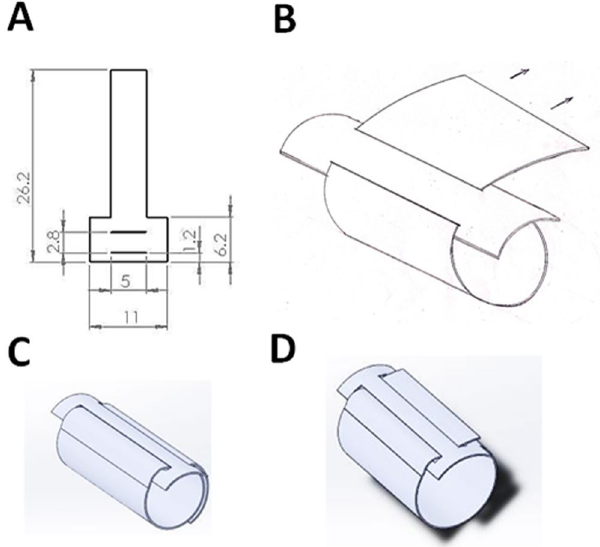
Figure 1. Dimensions of the stent components and the schematic design for self-lock characteristics. The stent element was cut from the film as shown ( A ). One side of the element (the strip) was glided through the two slits and rolled into a cable-tie type stent as shown ( B ). Before inflation, the stent can be tied on the preferred balloon size ( C ). Due to the geometry constrains of the double slits, once the stent is expanded, the strip is not able to slide backward ( D